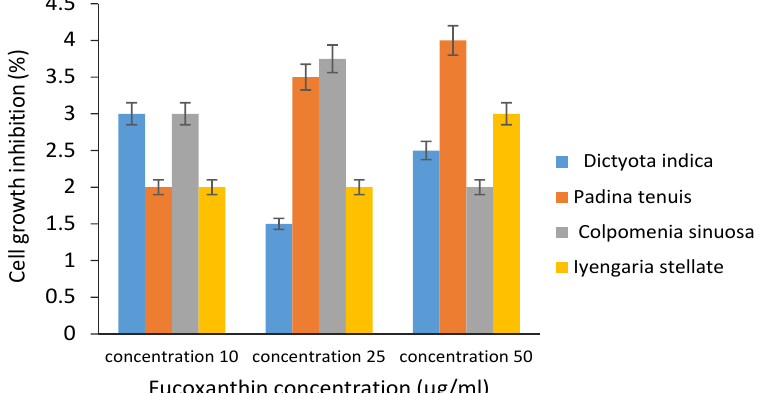
Fig. 5: Percentages of cell growth inhibition at different concentrations of fucoxanthin extract from four species of brown seaweeds (P. tenuis , C. sinuosa , I. stellate and D. Indica) at 24 h incubation time Data are expressed as mean±standared deviation (n=3)